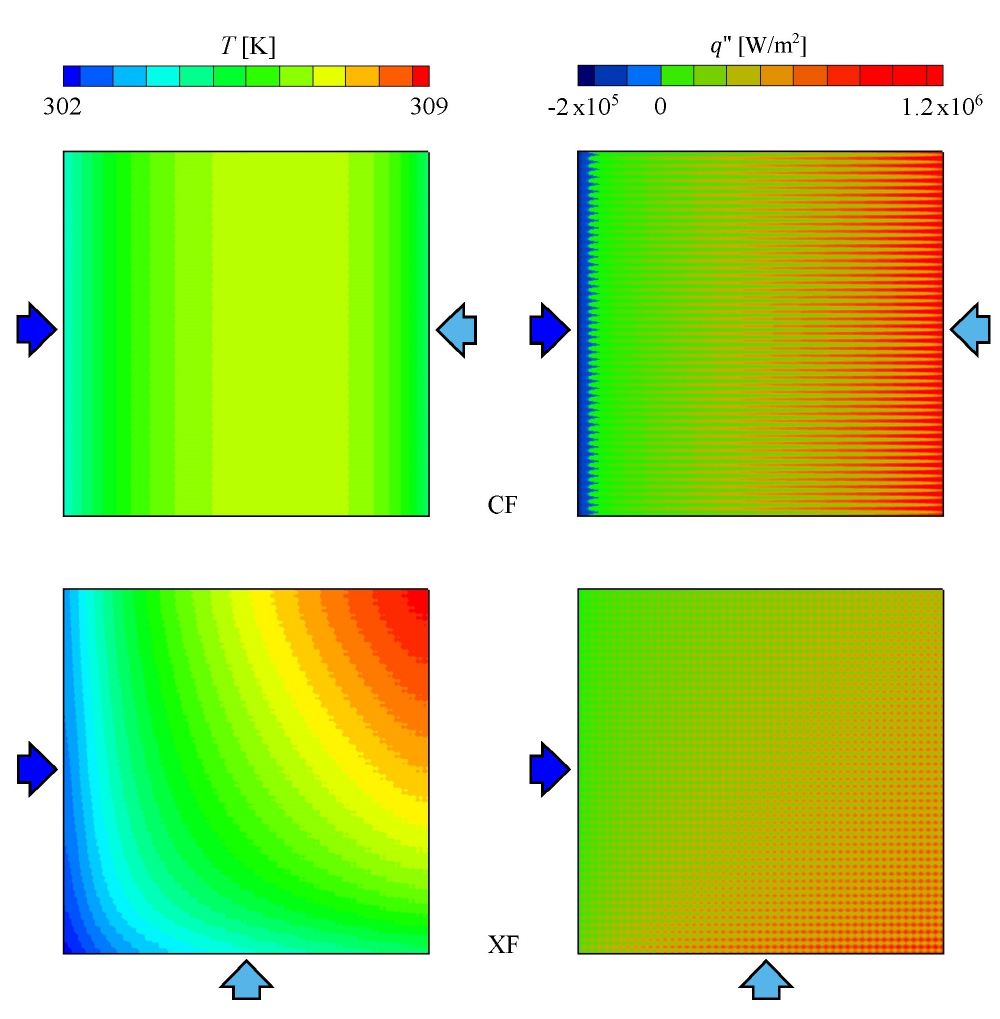
Figure 6. Temperature ( left ) and heat flux ( right ) distributions on the midplane between the bottom and the top layers in types CF and XF of DL-MCHSs for ˙ V = 5.0 mL/s (blue: negative heat flux; dark blue arrow: bottom layer; light blue arrow: top